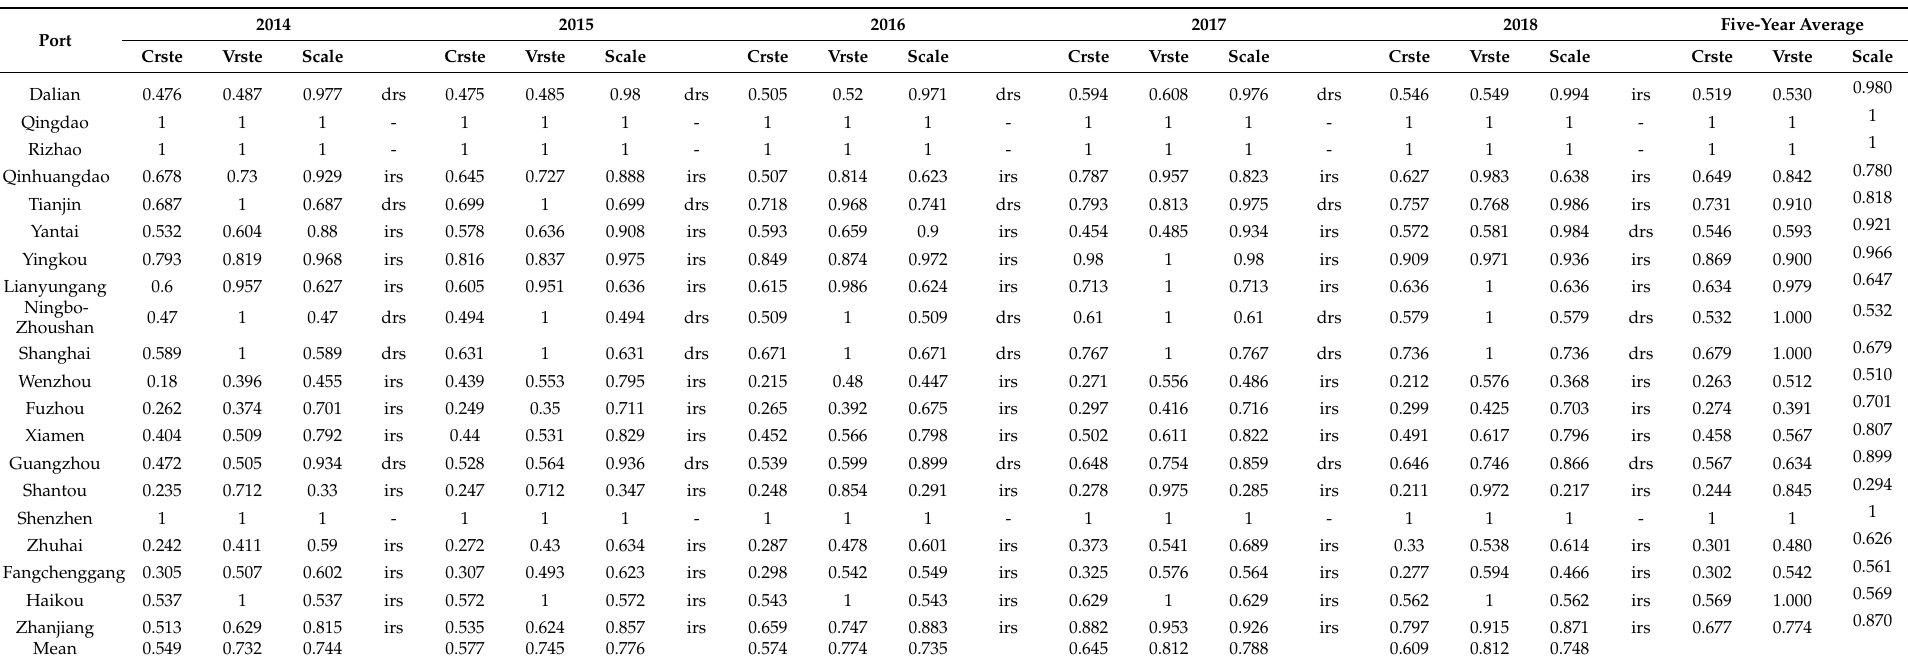
Table 2. The efficiency value of China’s coastal ports in stage I